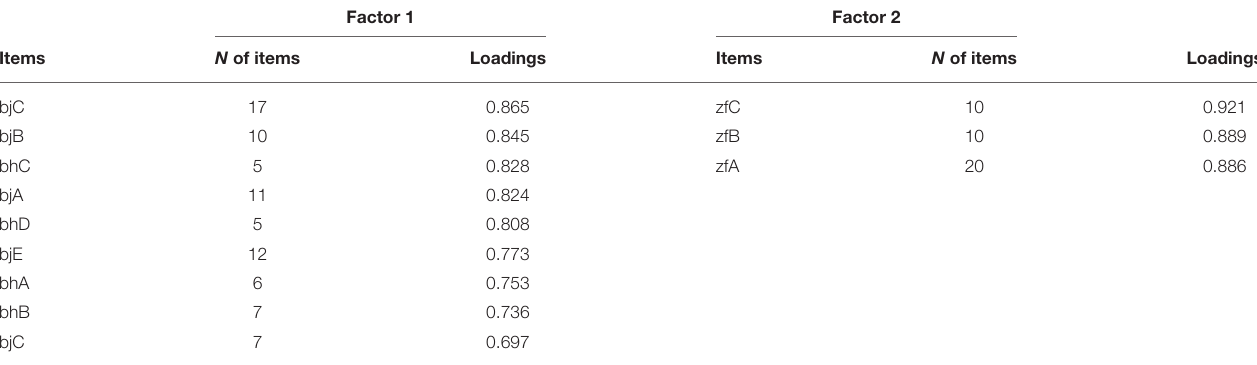
TABLE 3 | Exploratory factor analysis of each factor loading matrix for grades 1–2 scale (120 items).